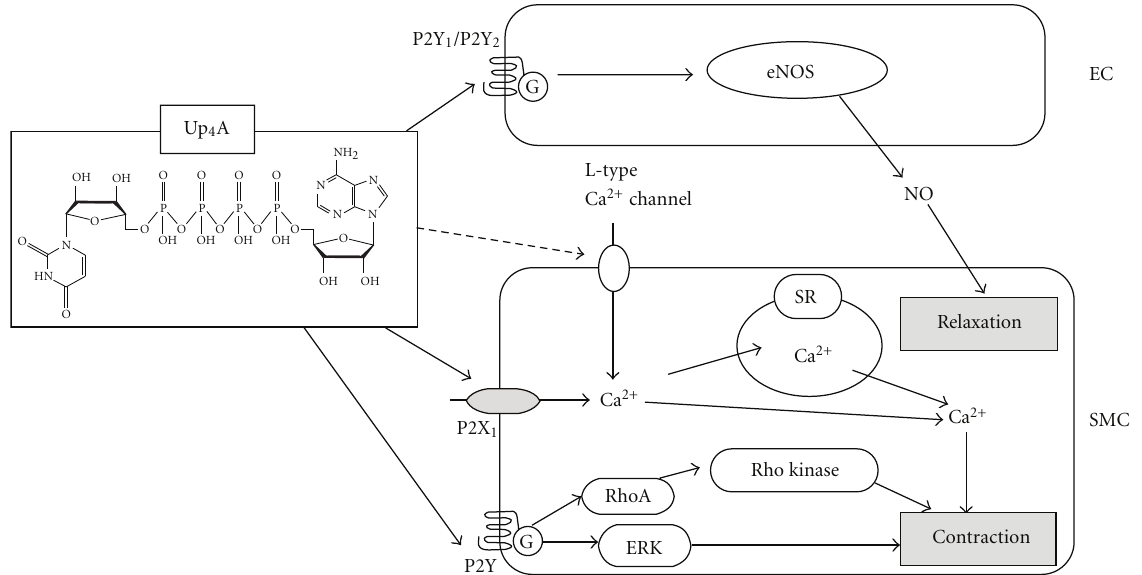
Figure 1: Up 4 A and vascular tone. Details are shown in the text. Up 4 A may directly or indirectly activate L-type Ca 2+ channel. NO: nitric oxide; eNOS: endothelial nitric oxide synthase; EC: endothelial cell; SMC: smooth muscle cell; SR: sarcoplasmic reticulum; ERK: extracellular signal regulated